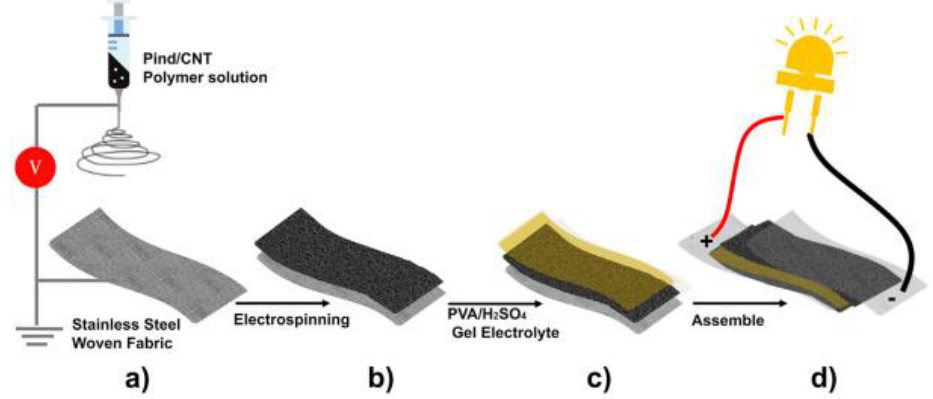
Figure 21. Fabrication of all-solid-state flexible supercapacitor. ( a ) Electrospinning of fibrous polyindole (Pind)/carbon nanotubes (CNT) membrane on a flexible stainless-steel woven fabric collector; ( b ) woven stainless current collector and layer of Pind/CNT nanofibers as electrode active materials; ( c ) application of polyvinyl alcohol (PVA)/H 2 SO 4 gel electrolyte prior to assembling into ( d ) a full symmetrical device (reproduced from reference [47] with permission. Copyright 2017, Elsevier).